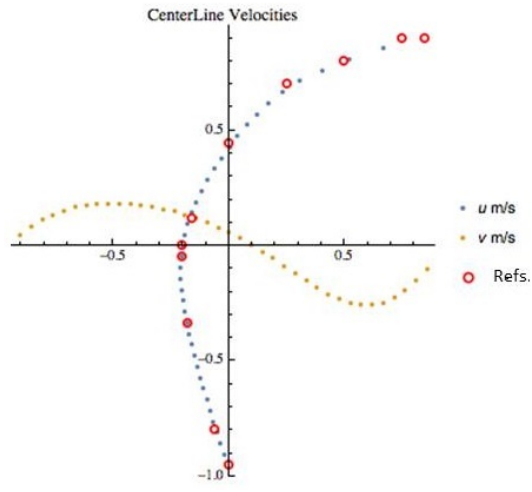
Figure 8. Calculated centerline velocity results compared with those of Refs. [25] and [27]. (Reproduced with permission from [21]).